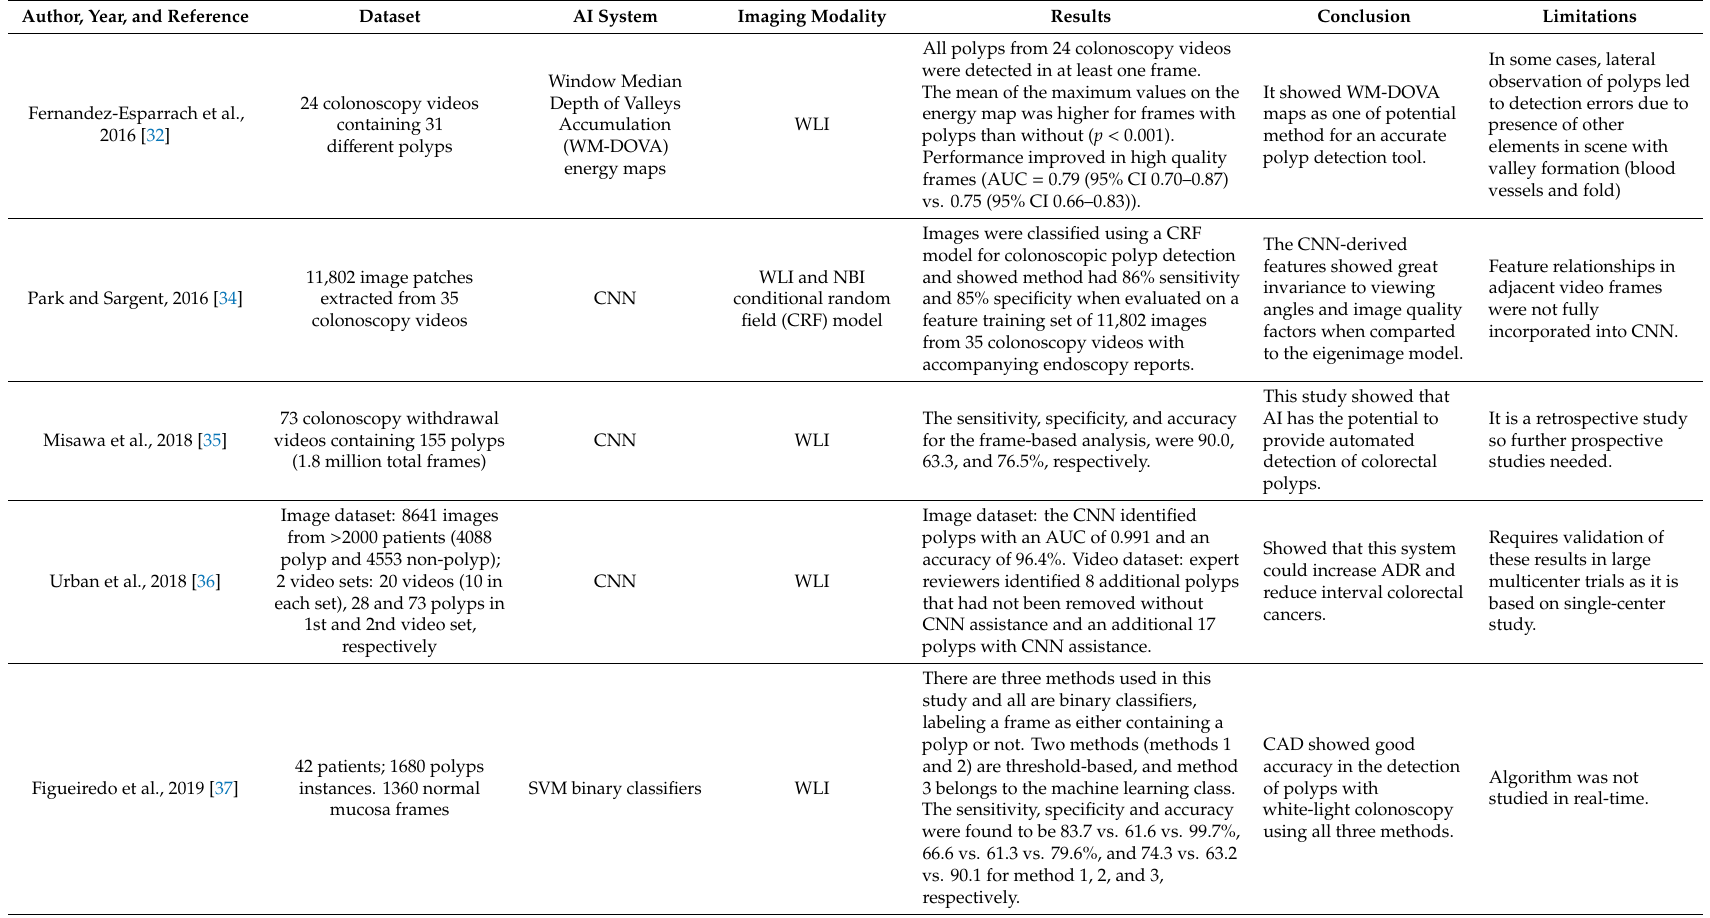
Table 1. Studies on artificial intelligence (AI) in polyp